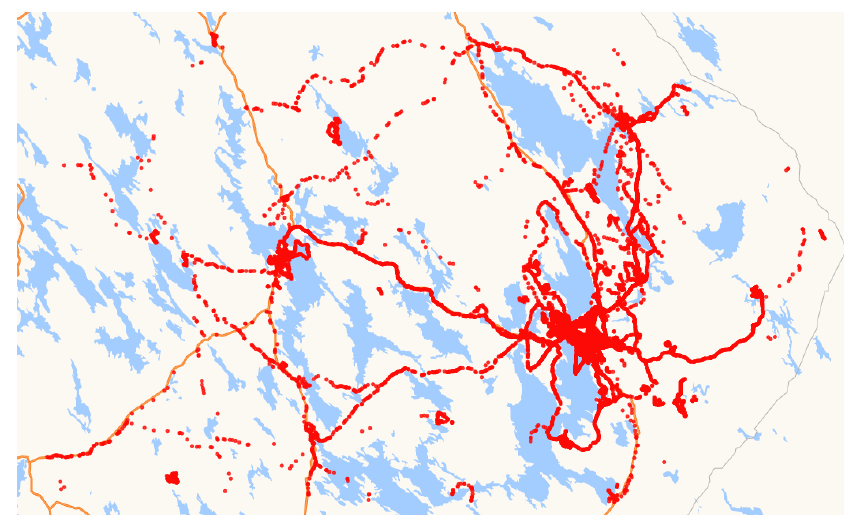
Figure 3. The spatial distribution of the multi-source data trajectory